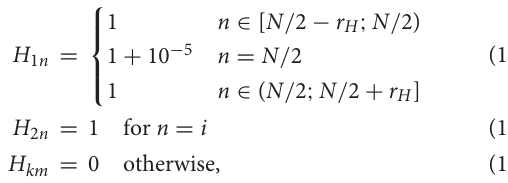
Figure 2 for illustration. The sensitivity function of the nonlocal observation has a small peak in its center, which permits to localize the observation in the center of the sensitivity function, cf. section 2.4.